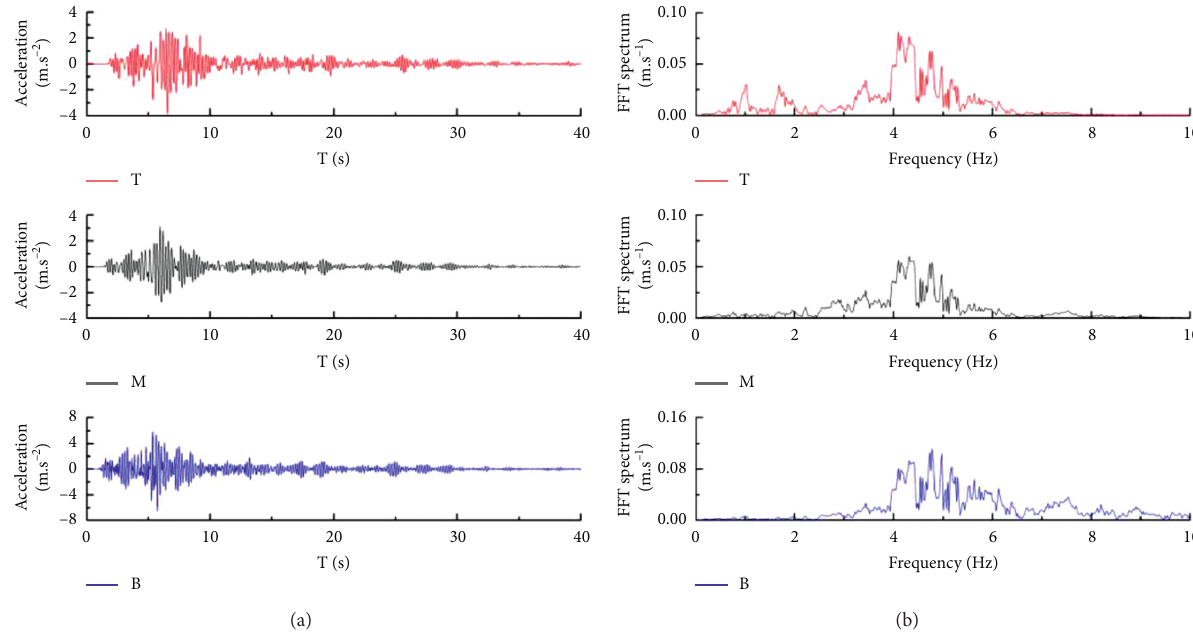
Figure 13: Ground motion characteristics under Minxian seismic excitation: (a) acceleration time histories and (b) spectrum characteristics.